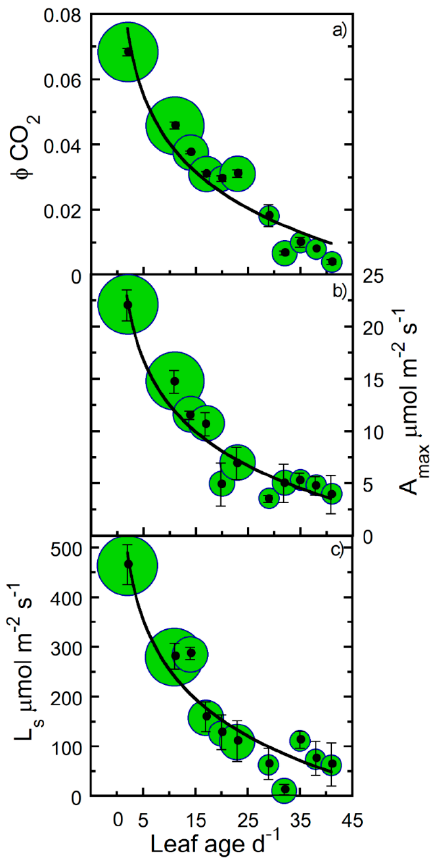
Figure 1. The quantum yield ( φ CO 2 ), maximum photosynthesis (A max ), and leaf light saturation (L s ) of hemp leaves as a function of leaf age. Binned averages per three-day collection sequence (means ± SE) of measured changes in ( a ) φ CO 2 , ( b ) A max , and ( c ) L s versus leaf age. Samples were pooled for treatments and crown position, and sample size in bins is indicated by bubble diameter (n = 3–18 for φ CO 2 , A max , and L s ). Solid lines are logarithmic regression curves fitted to the entire data set.